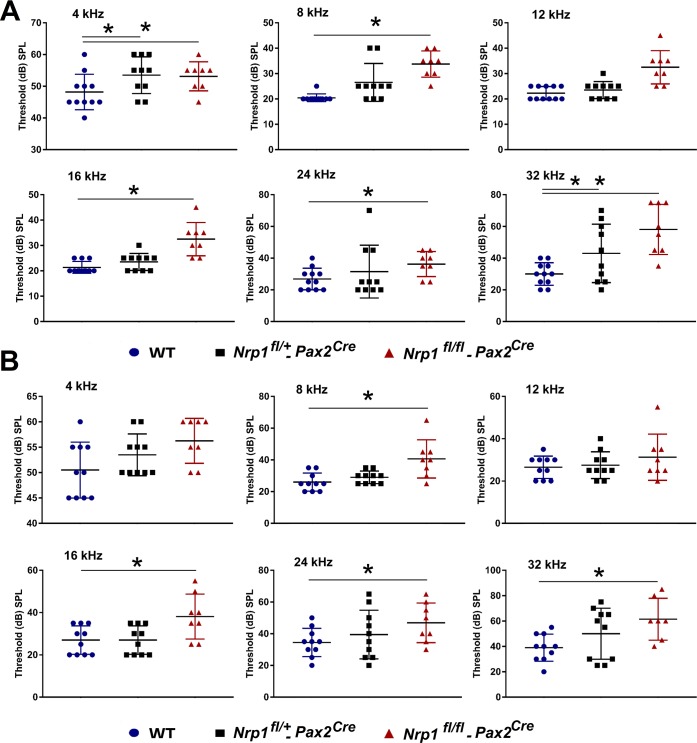
ABR for WT, Nrp1fl/+;Pax2Cre, and Nrp1fl/fl;Pax2Cre mice at 2 and 4 months of age.ABR results of the 2-month-old mice (Panel A) showed that the hearing thresholds of the Nrp1fl/fl;Pax2Cre group (n = 8) were significantly higher than WT controls (n = 11) at 4kHz, 8kHz, 16kHz, 24kHz, and 32kHz (A). At 4 months of age (Panel B), Nrp1fl/fl;Pax2Cre mice (n = 8) showed elevated hearing thresholds at all tested frequencies except 12 kHz when compared to WT mice (n = 11) (B).